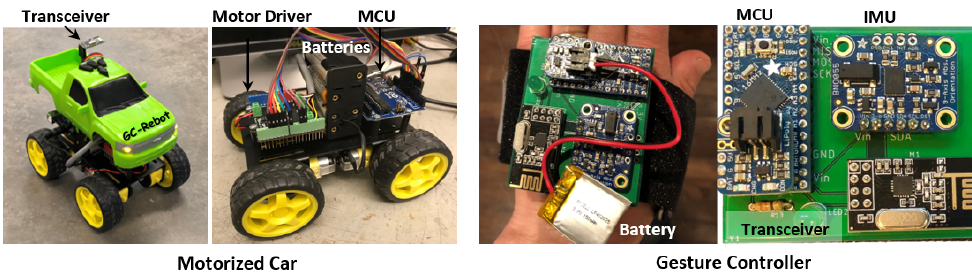
Figure 1. The gesture-controlled rehabilitation robot (GC-Rebot) includes a (left) motorized car with a microcontroller (MCU), motor driver, and radio transceiver, which are powered by eight AA batteries, and a (right) gesture controller with an IMU, radio transceiver, and miniature MCU, which are powered by a rechargeable lithium ion